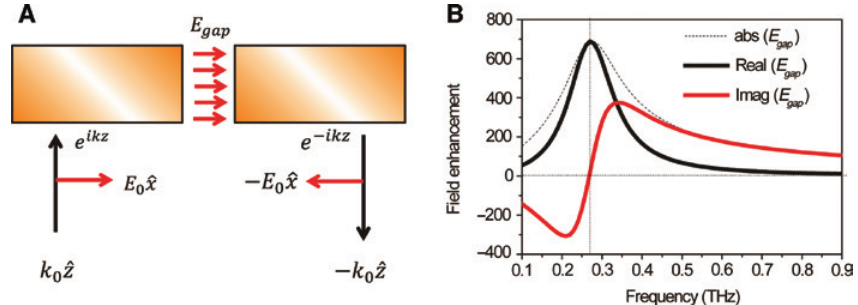
Figure 5: Phase relation between incident, reflected, and diffracted waves from the nanogap layer. (A) Cross-sectional schematics for the relative field direction. The phase is set such that the incident wave has zero phase shift at the gap entrance. (B) Calculated complex near field at the gap, with respect to the incident wave. At resonance the near field aligns completely with the incident electric field, being out of phase with the reflected light from metal